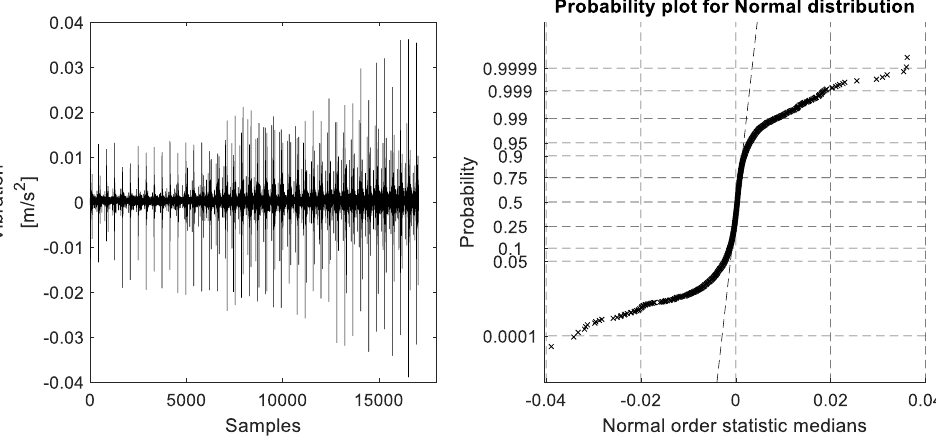
Figure 12. Raw vibration data signal from accelerometer #2 and its ProbPlot in inner-race fault (IRF) case under constant speed environment.